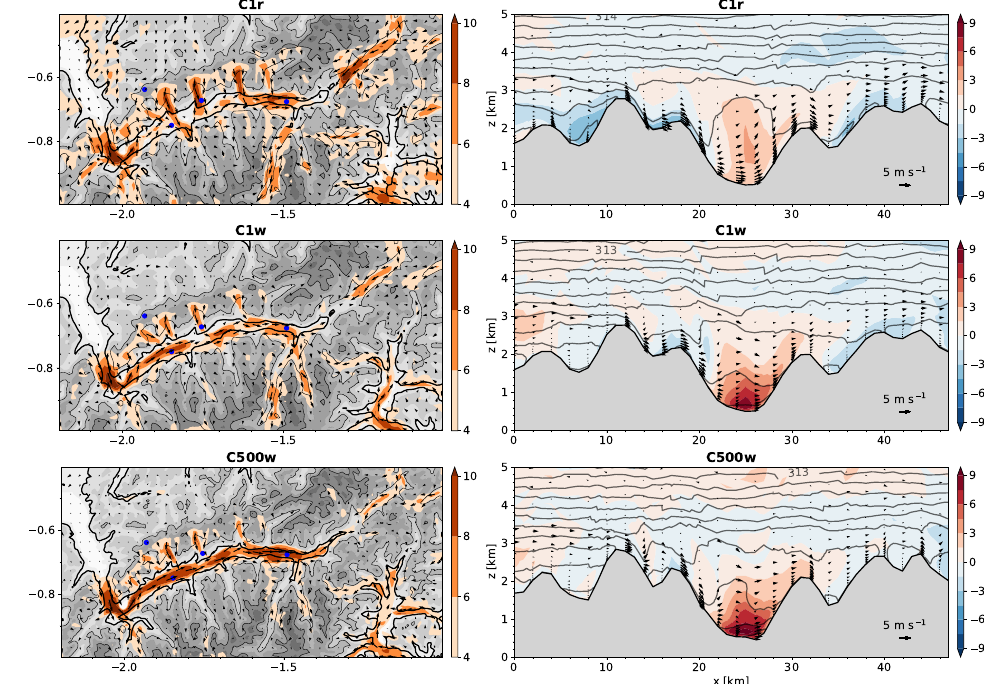
Figure 11. As in Figure 10, but for 10 September 2016 at 16:00. In order to further assess the simulations and obtain an idea of the true flow pattern in the valley at the location of Sion, the simulated wind evolution throughout the atmosphere is compared with observations in Figure 12. The basic features of the observed evolution are similar to the monthly average showed in Figure 6, a low-level up-valley jet during daytime, an upper-level maximum in the nighttime down-valley flow and wind reversals originating at the surface and propagating upwards. The evolution above about 1000 m MSL is, however, highly variable and indicative of the impact of the cross-valley flow. The cross-valley flow can be clearly seen above 2000 m MSL starting at 12:00 and down to 1000 m MSL at 16:00. While none of the simulations are perfect, C500w captures both the development of the strong low-level up-valley flow and of the cross-valley flow at higher levels. In particular, the former is poorly represented in the other two simulations. For an easier quantitative assessment, we turn to vertical profiles of wind and potential temperature at 16:00 at Sion (see Figure 13). The observed wind profile clearly shows a jet-like structure with a maxima at 700 m MSL (220 m AGL). Within the jet region, the wind is in the along-valley direction. The wind speed reaches a minimum at 1000 m MSL and increases to a broad second maxima at 1600 m MSL. It can be clearly seen that the upper level maxima is related to the cross-valley flow and that the influence of the flow reaches down to 900 m MSL, just 400 m AGL. Abrupt changes in the observed wind direction with height suggest that the flow might be rather variable in time, and possibly also